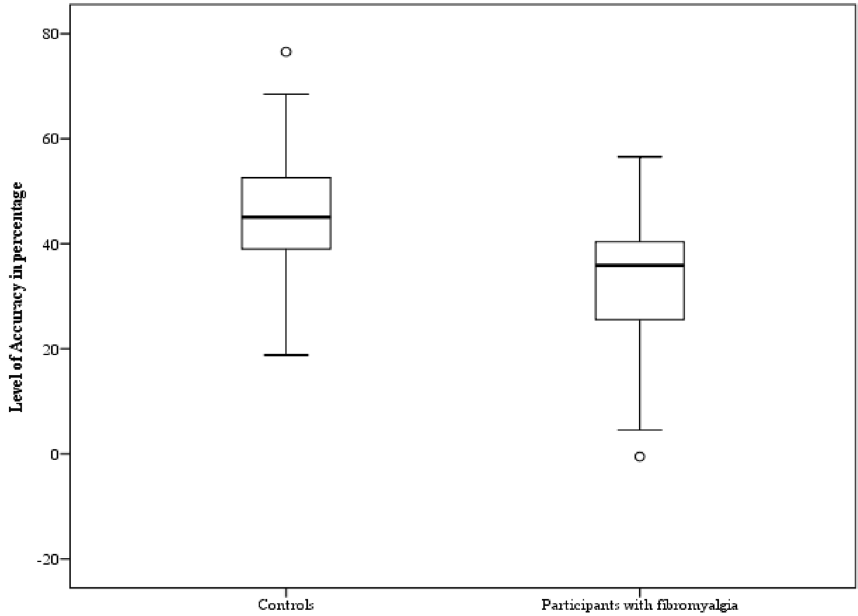
Figure 5. The mean relative to the level of accuracy expressed in percentage in the case of angry expressions on the y-axis is shown for the two groups (controls vs participants with fibromyalgia). The minimum, the lower quartile, the median, the upper quartile, the maximum, and the outliers are